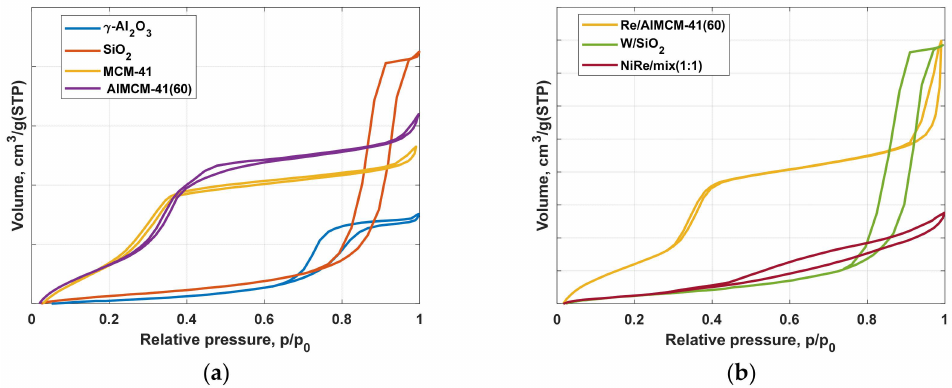
Figure 2. N 2 -physisorption isotherms of the used support materials ( a ), as well as for the fresh and tested catalysts for the metathesis of ethene and trans-butene towards propene ( b